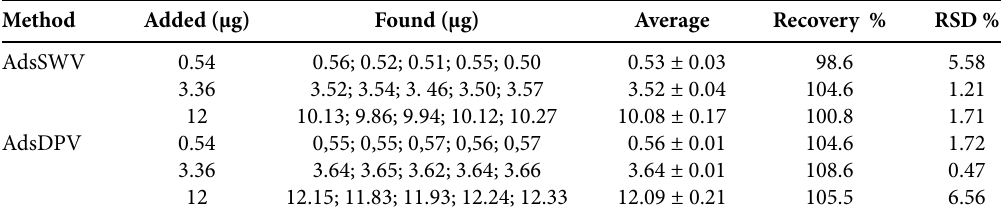
Table 4. Main recovery results and the relative standard deviations for the determination of HQ in pharmaceutical cream